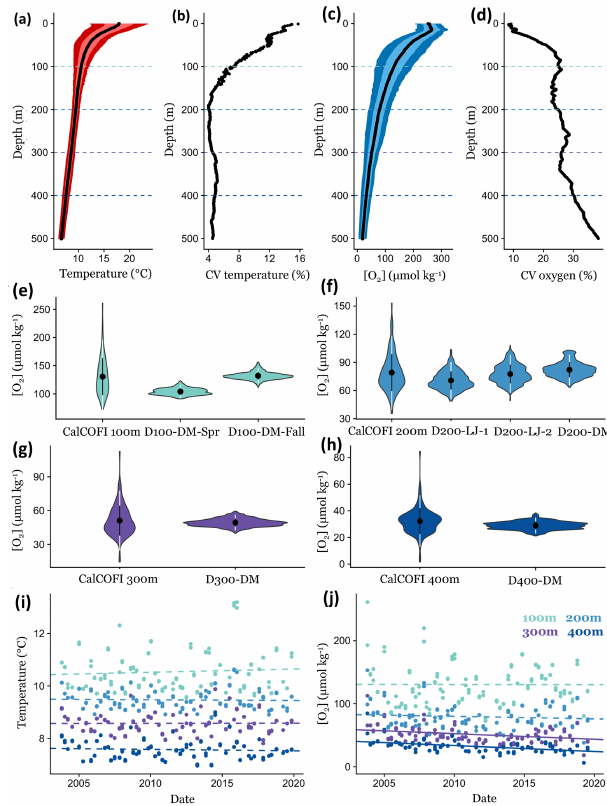
Figure 7. Comparing short-term environmental variability from DOV BEEBE deployments to longer-term trends using CTD casts at a nearby CalCOFI station (93.3 28.0). Mean temperature (a) and oxygen (c) conditions through the water column (0–500m) using CalCOFI CTD casts from October 2003 to November 2019; light and dark colors indicate the variance around the mean and repre- sent ± 1 and 2SD, respectively. Panels (b) and (d) show how the coefficient of variation (CV) for temperature and oxygen changes through the water column. Dotted lines in (a) – (d) indicate 100, 200, 300, and 400m depths, and data are extracted for these depths for (e) – (j) . In (e) – (h) , violin plots show the data distribution of oxygen measurements from ∼ 16 years of CalCOFI quarterly cruises com- pared to ∼ 3-week Nanolander deployments at 100 (e) , 200 (f) , 300 (g) , and 400m (h) . Violin plots show the mean ± 1SD (white) and ± 2SD (black). Panels (i) and (j) examine changes in temperature (i) and oxygen (j) conditions through time at 100, 200, 300, and 400m. Dotted lines indicate nonsignificant linear relationships; solid lines indicate significant trends ( p< 0 .